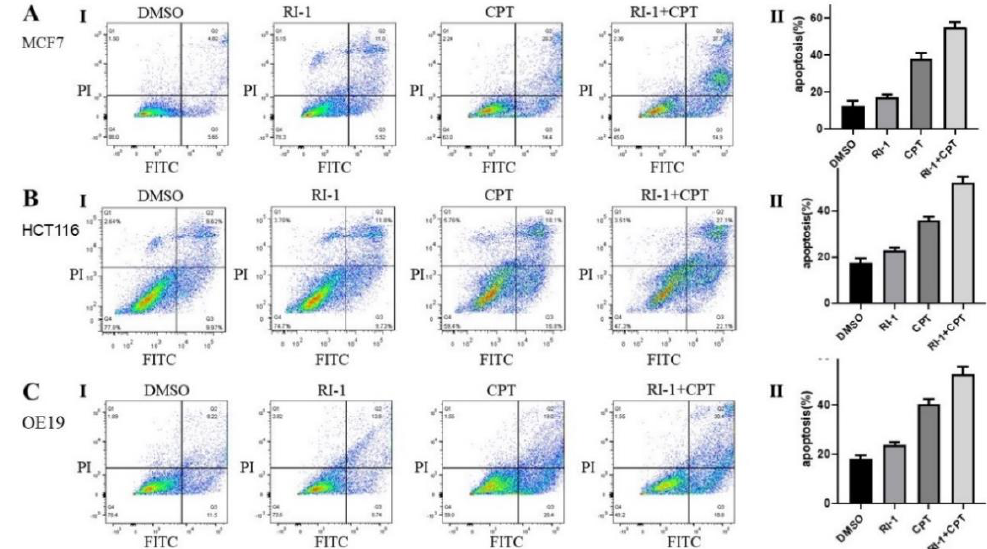
Figure 4. RAD51 inhibitor potentiates cytotoxicity of camptothecin in cancer cell lines. Esophageal adenocarcinoma (OE19, FLO-1), colon (HCT116) and breast (MCF7) cancer cell lines were treated with RAD51 inhibitor (RI-1), camptothecin (CPT) or combination of both (RI-1 + CPT) at different concentrations for 48 h and evaluated for cell viability as described in Methods. Errors bars repre- sent SDs of triplicate assays.